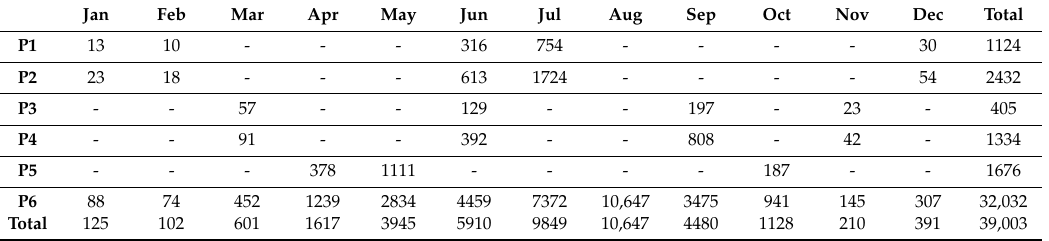
Table 4. Distribution of the electrical demand of the system without management of the hourly demand (MWh).